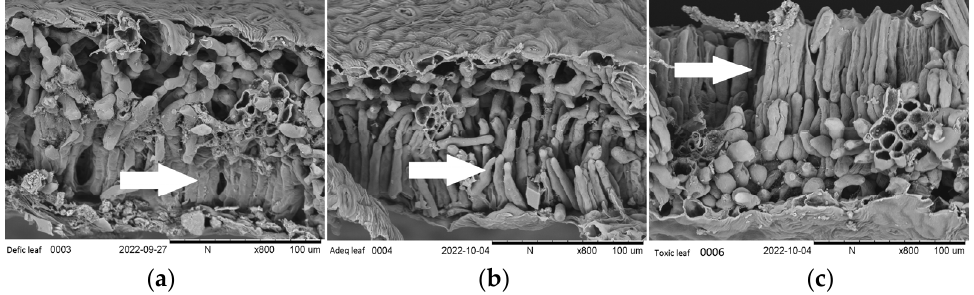
Figure 2. Cross-sectional micrograph of cherry leaves with three concentrations of soil boron availability, deficient ( a ), adequate ( b ), and toxic ( c ) (0.04, 1.10, 3.75 mg kg − 1 ), respectively. SEM × 800.